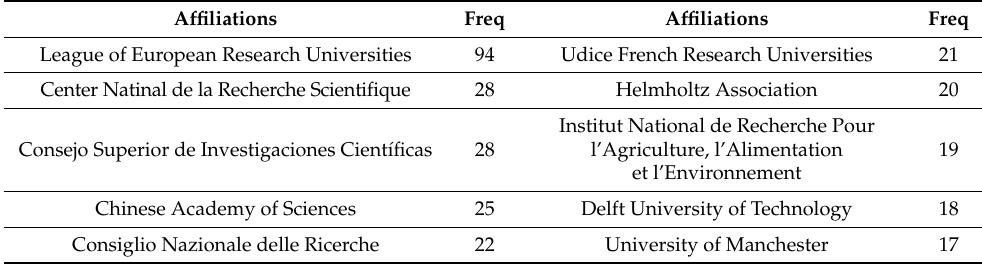
Table 3. List of Top 10 institutions with the Most Published